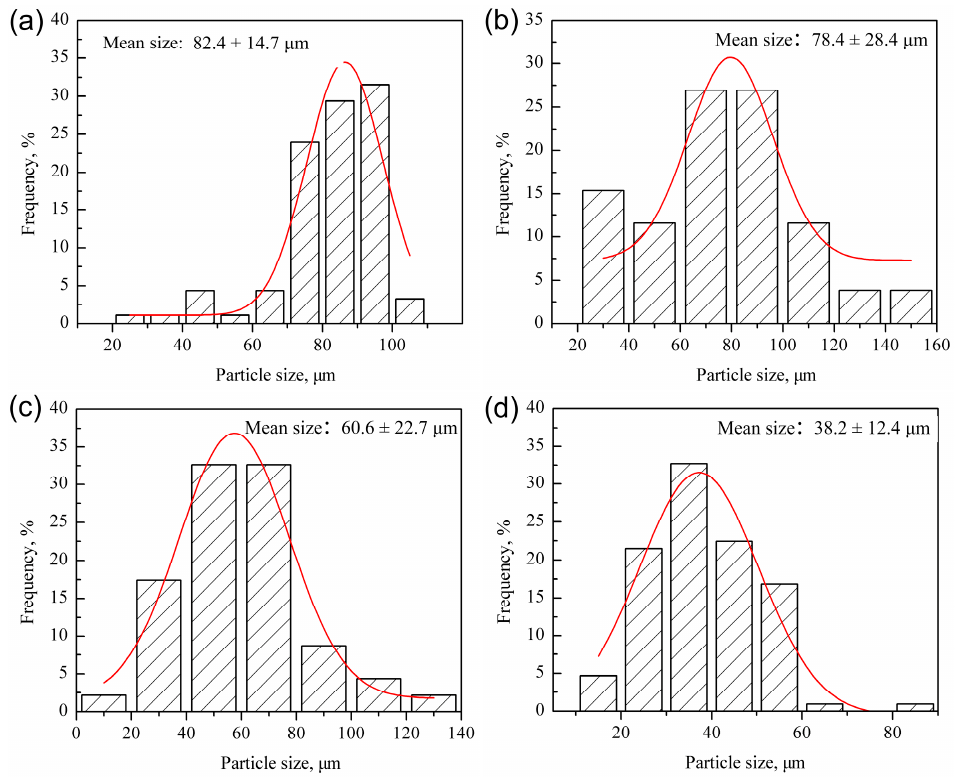
Figure 3. Particle size distribution of different powders: ( a ) pre-alloyed; ( b ) MP; ( c ) MX; ( d ) ODS.